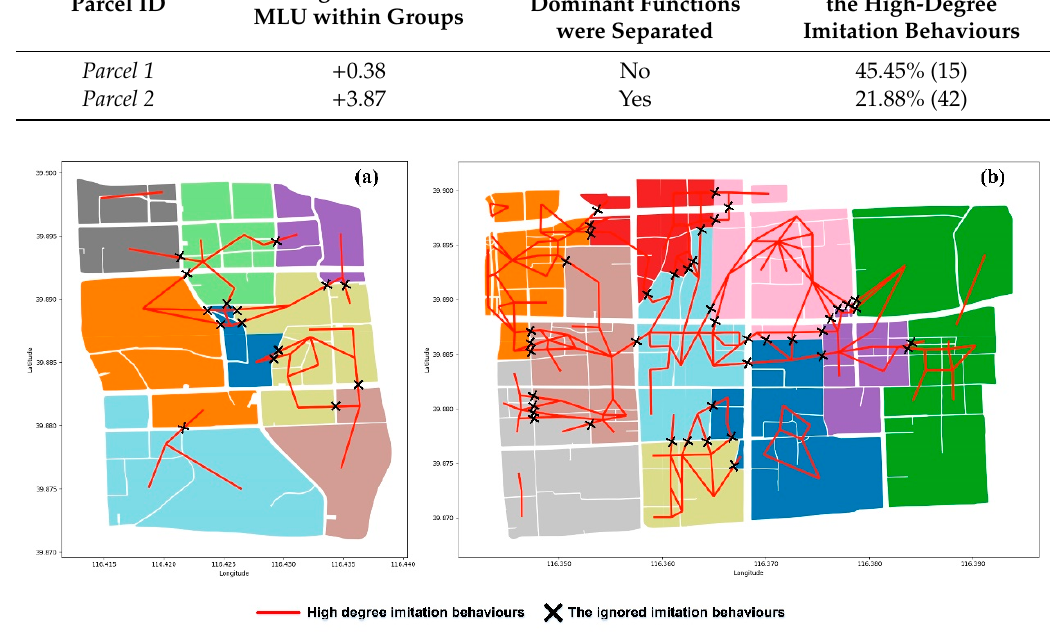
Figure 15. The ignored imitation behaviours among groups: ( a ) grouping result of Parcel 1 and ( b ) grouping result of Parcel 2. Table 4. Analysis of parcel grouping results based on infiltration behaviours (k-means++).